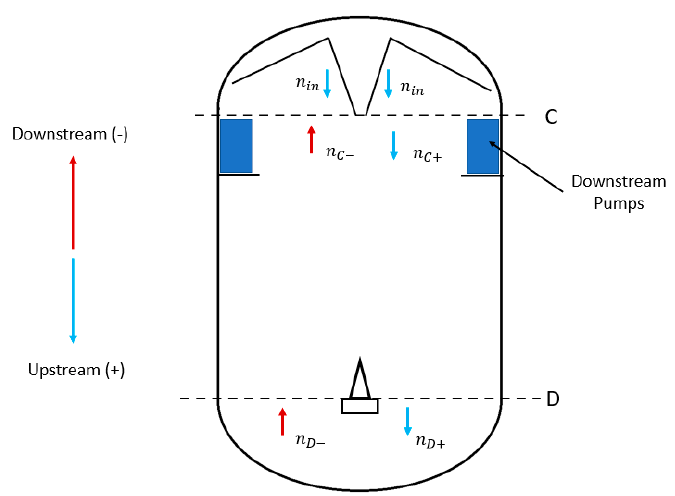
Figure 5. Schematics of the IV10 vacuum chamber and the parameters used for the 1D background flow model.